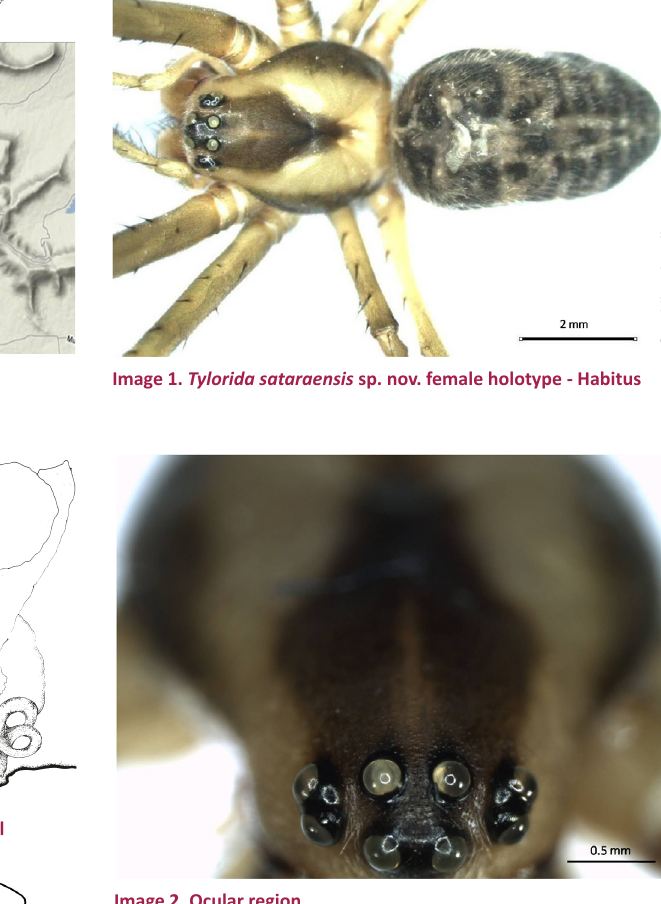
than wide margined black with tips bent outwards, both brown with yellowish edges. Legs yellow with